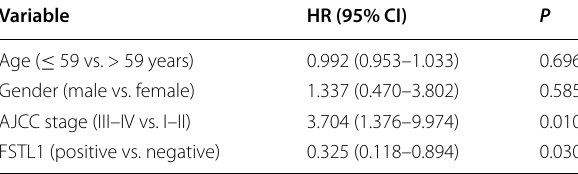
Table 4 Factors predicting disease-specific survival of ccRCC patients in multivariate Cox proportional